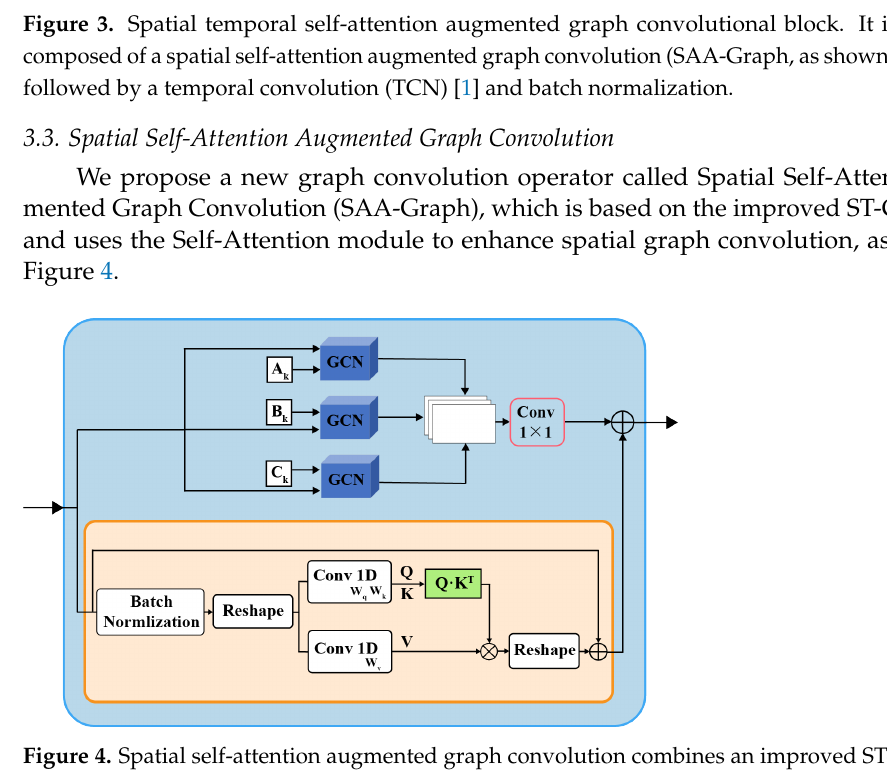
Figure 4. Spatial self-attention augmented graph convolution combines an improved ST-GCN block and a self-attention module to enhance spatial graph